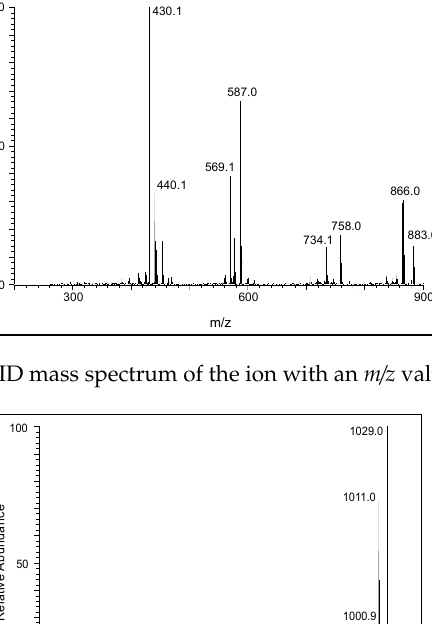
Figure 9. The CID mass spectrum of the ion with an m/z value of 736 amu.